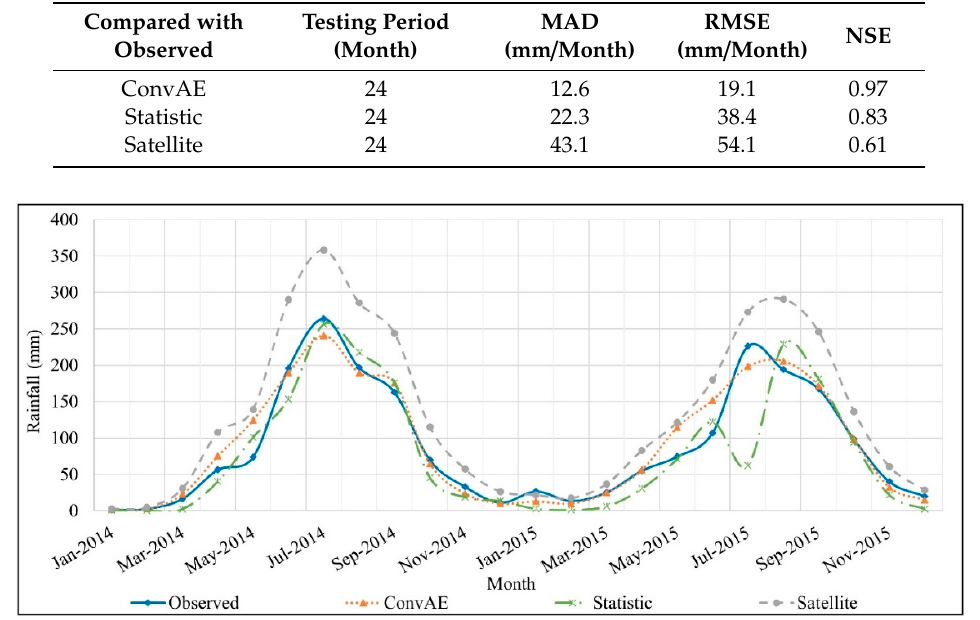
Figure 8. Comparing the correlation of the monthly total precipitation of the data sources over the Mekong basin during the testing period.